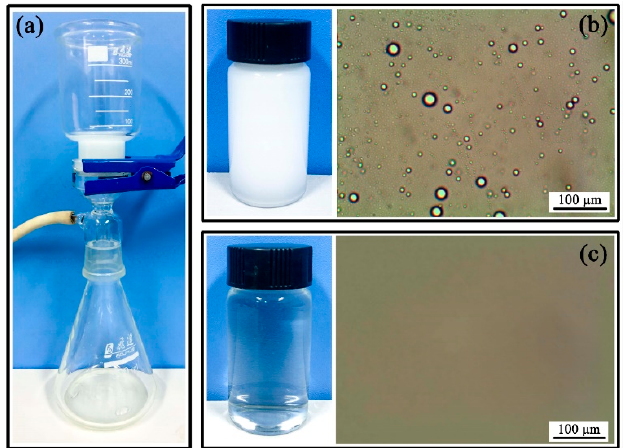
Figure 10. ( a ) The digital image of the setup for separating toluene-in-water emulsion. The photographs and microscopic images of toluene-in-water emulsion ( b ) before and ( c ) after filtration.